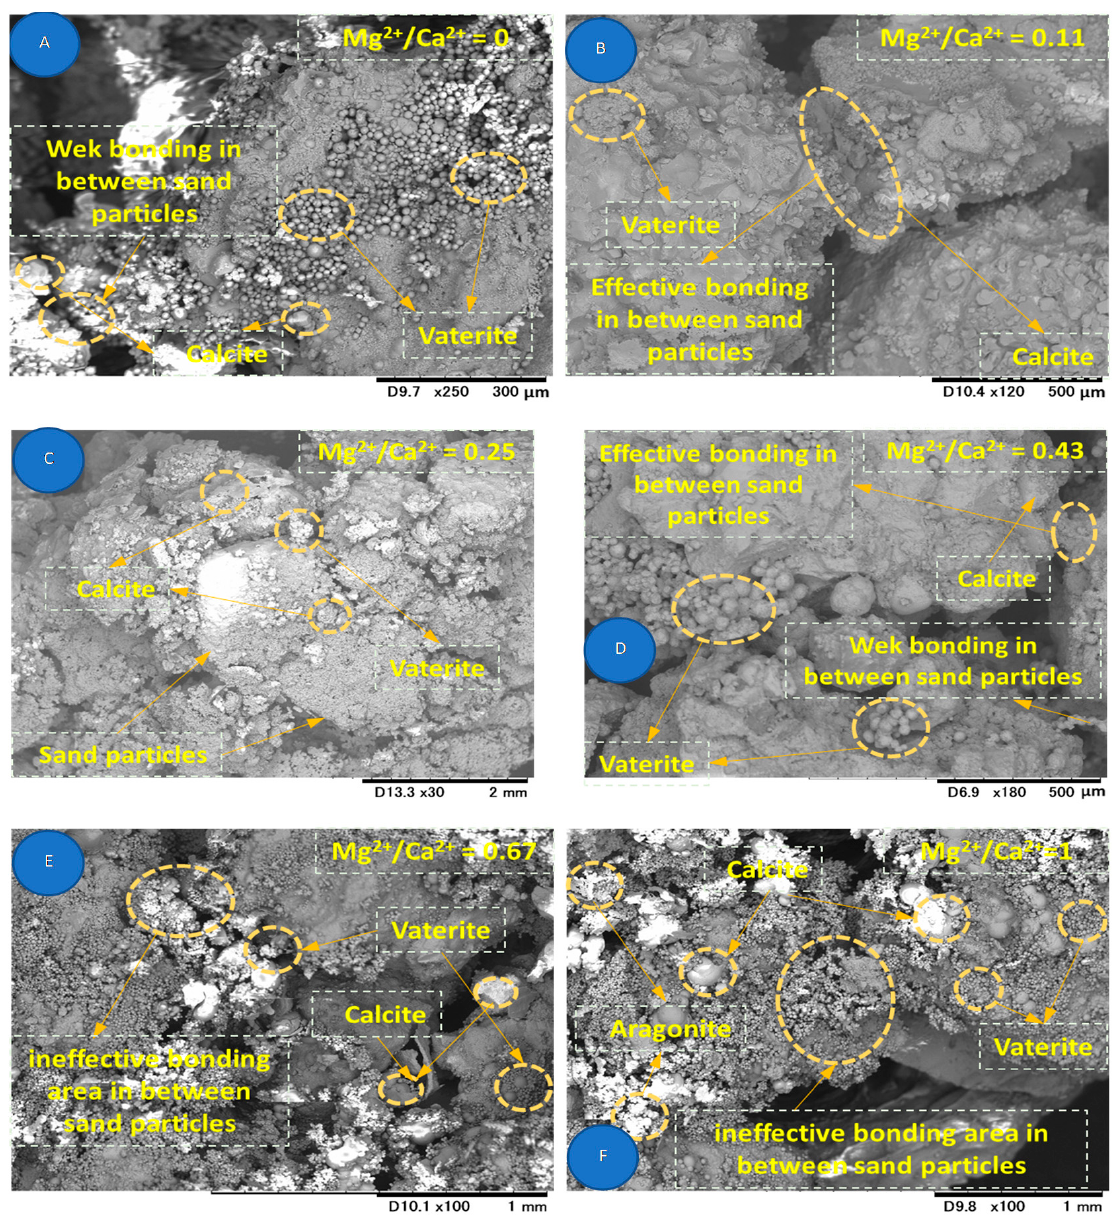
Figure 14. SEM images showing the efficacy and bonding patterns of CaCO 3 crystals in between the sand particles ( A – F ).